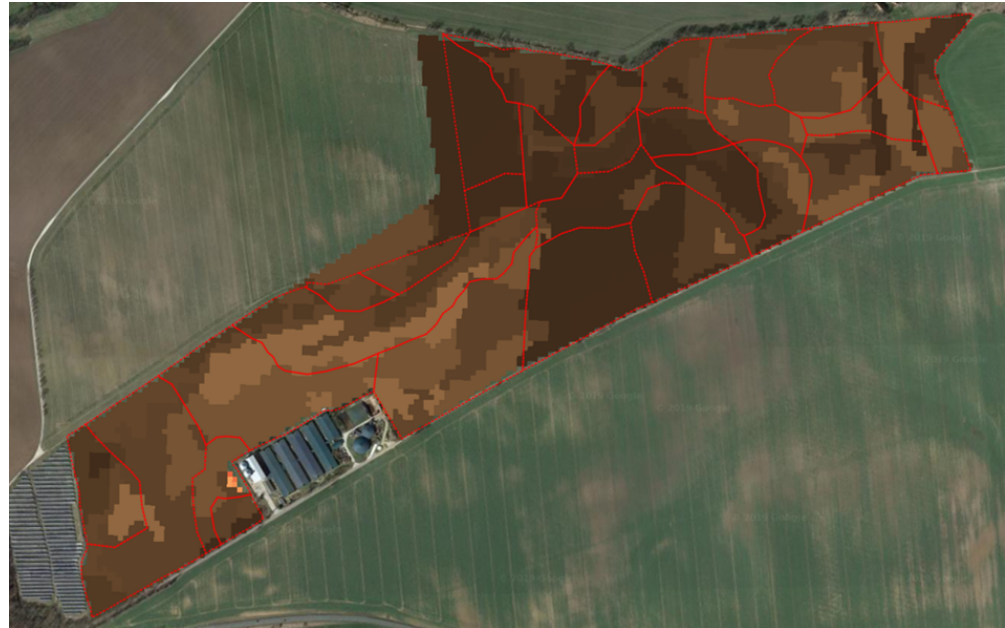
Figure 3. Soil zoning on the field “Stadtfeld”, Germany. Coloured areas depict satellite based soil zoning as presented in this paper and red lines show soil zones as previously derived by an expert using field sampling and historical soil map information [46].